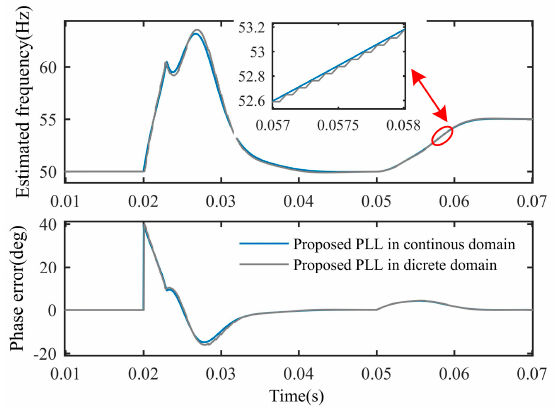
Figure 19. The discretization effect of the proposed PLL.